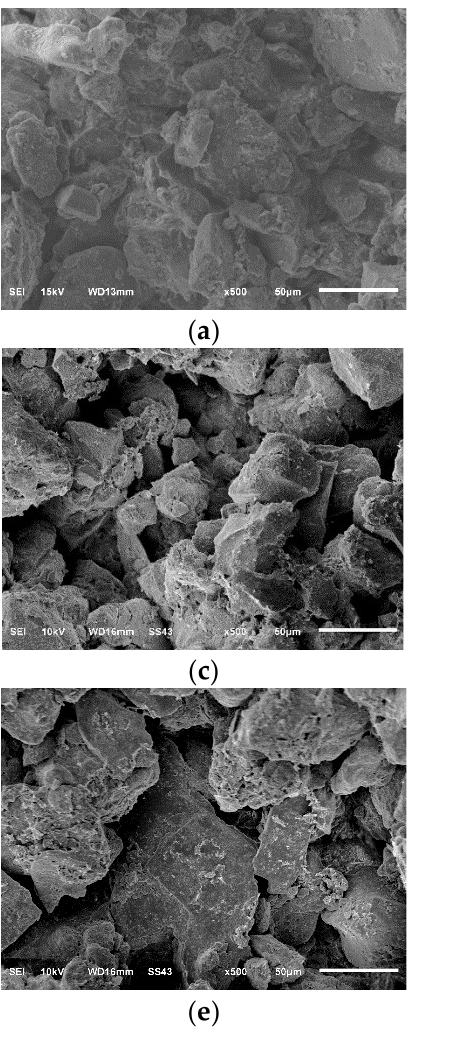
Figure 8. SEM images of remolded loess at different freeze–thaw cycles (500 times). ( a ) The number of freeze–thaw cycles is 0. ( b ) The number of freeze–thaw cycles is 2. ( c ) The number of freeze–thaw cycles is 6. ( d ) The number of freeze–thaw cycles is 10. ( e ) The number of freeze–thaw cycles is 15. ( f ) The number of freeze–thaw cycles is 20.